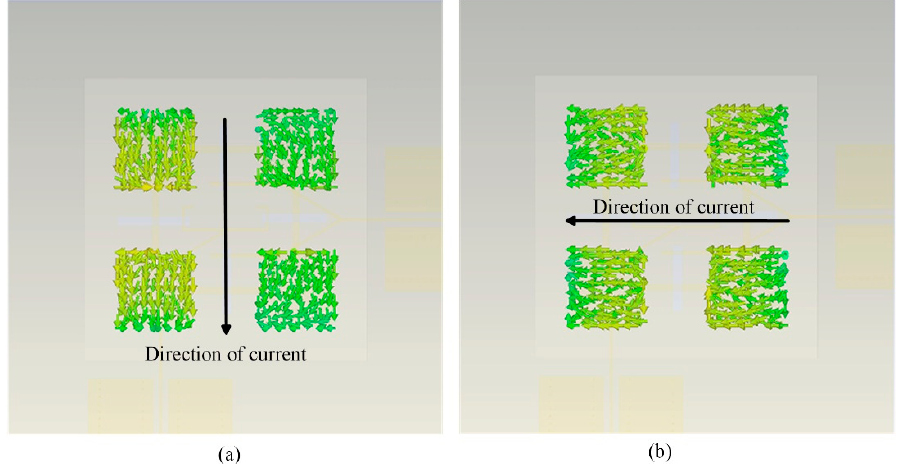
Figure 9. Simulation surface currents at 5.8 GHz when ( a ) Port 1 is excited and ( b ) when Port 2 is excited.